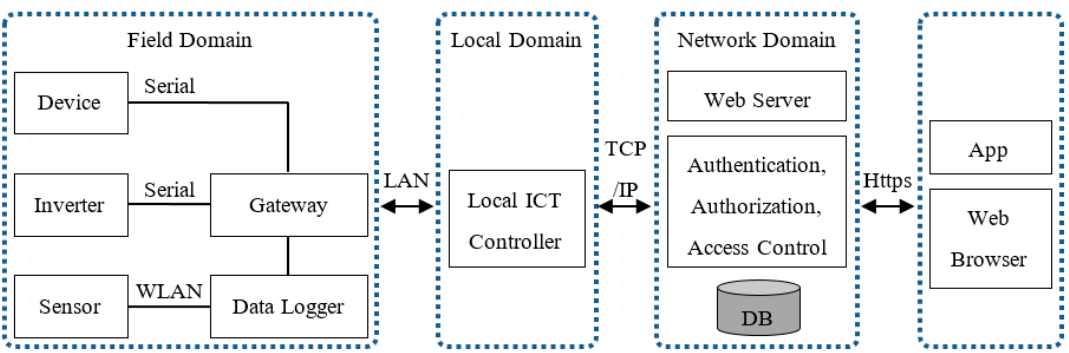
Figure 8. Data-collection process.